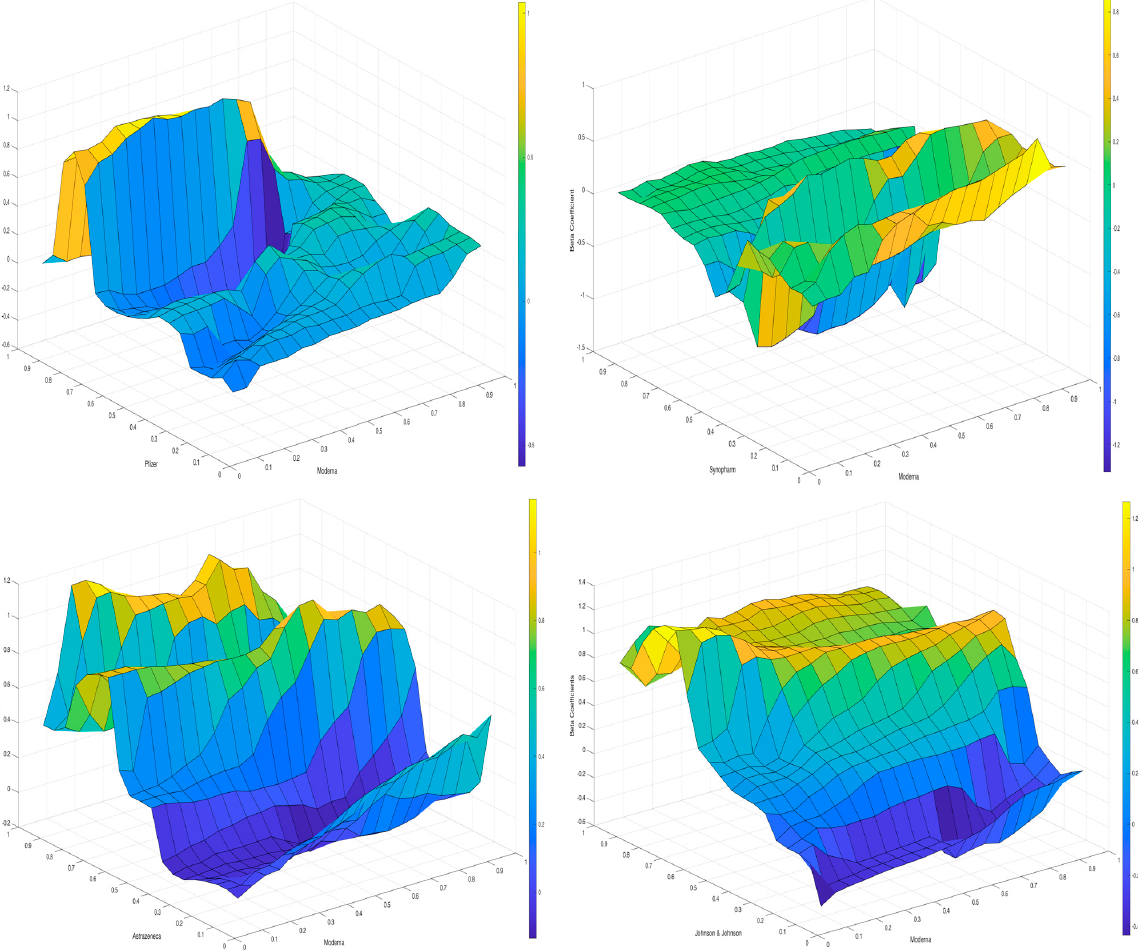
Figure 14. From Moderna to the other respective markets.